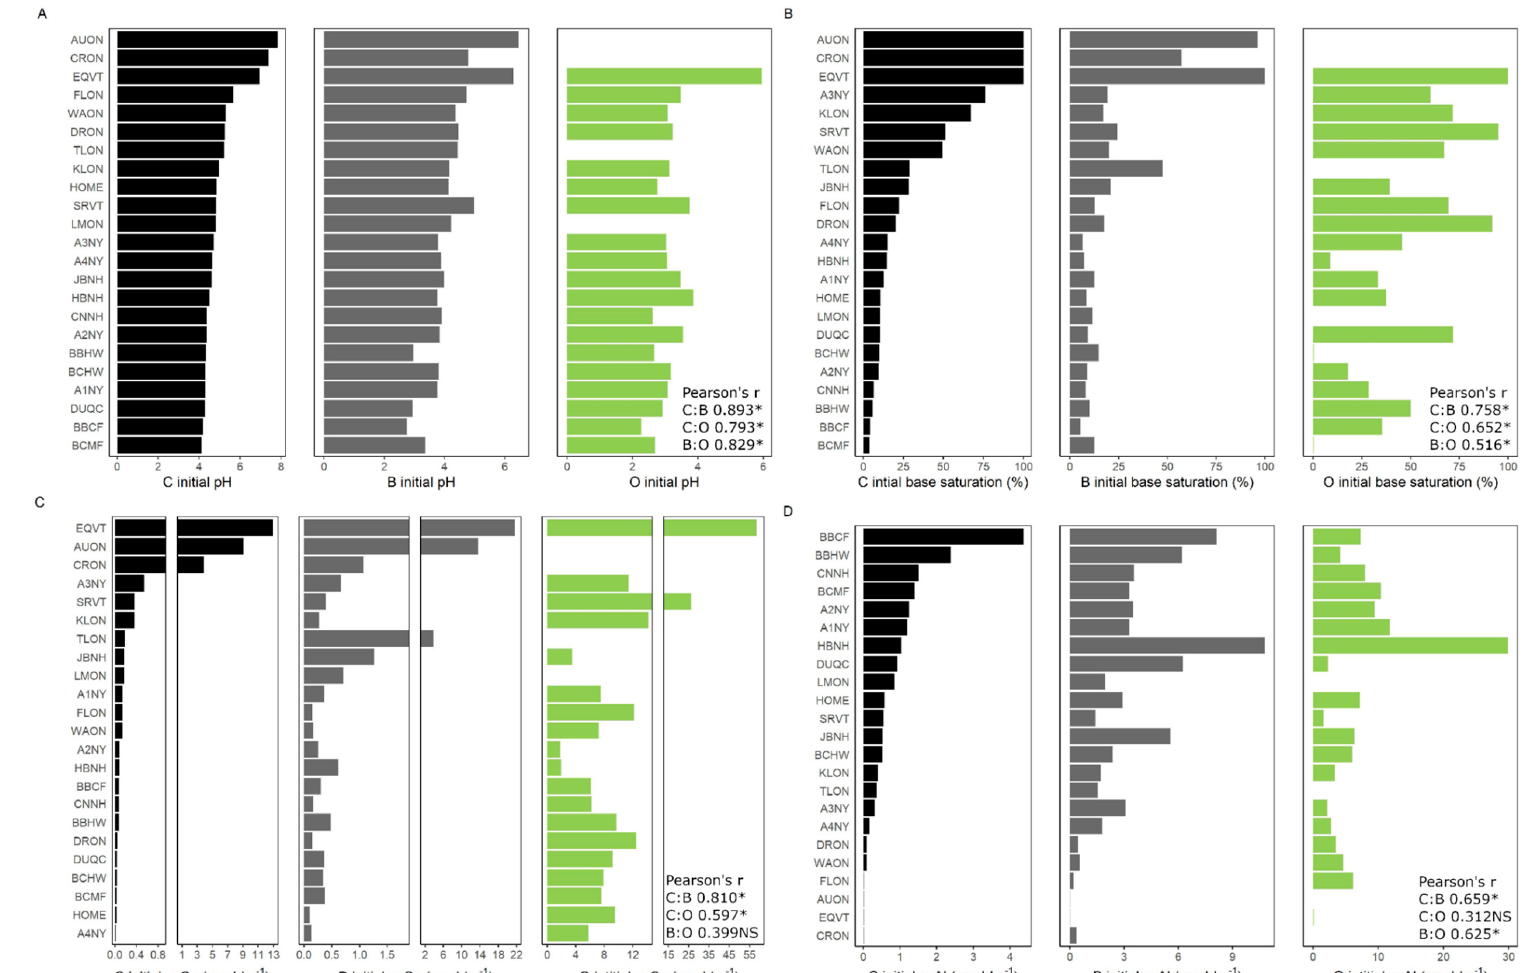
Figure 4. ( A ) Initial pH, ( B ) base saturation, ( C ) exchangeable Ca and ( D ) exchangeable Al in the C, B and O horizons for soil resampling sites in Eastern Canada and the Northeastern United States. Pearson’s r values marked with * indicate significance at p < 0.05 or NS (not significant).